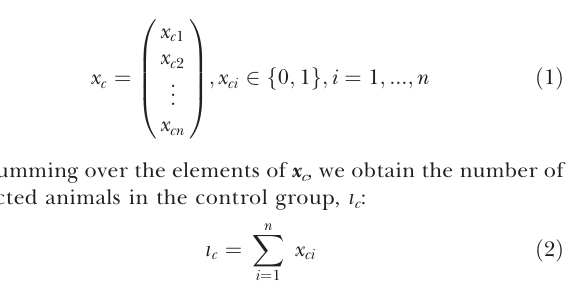
Figure 1. Single and Repeated Low-Dose Challenge Designs Figure shows designs for single (A) and repeated (B) low-dose challenge designs. Small arrows denote challenges, and white and red symbols denote uninfected and infected animals, respectively. DOI: 10.1371/journal.pmed.0020249.g001